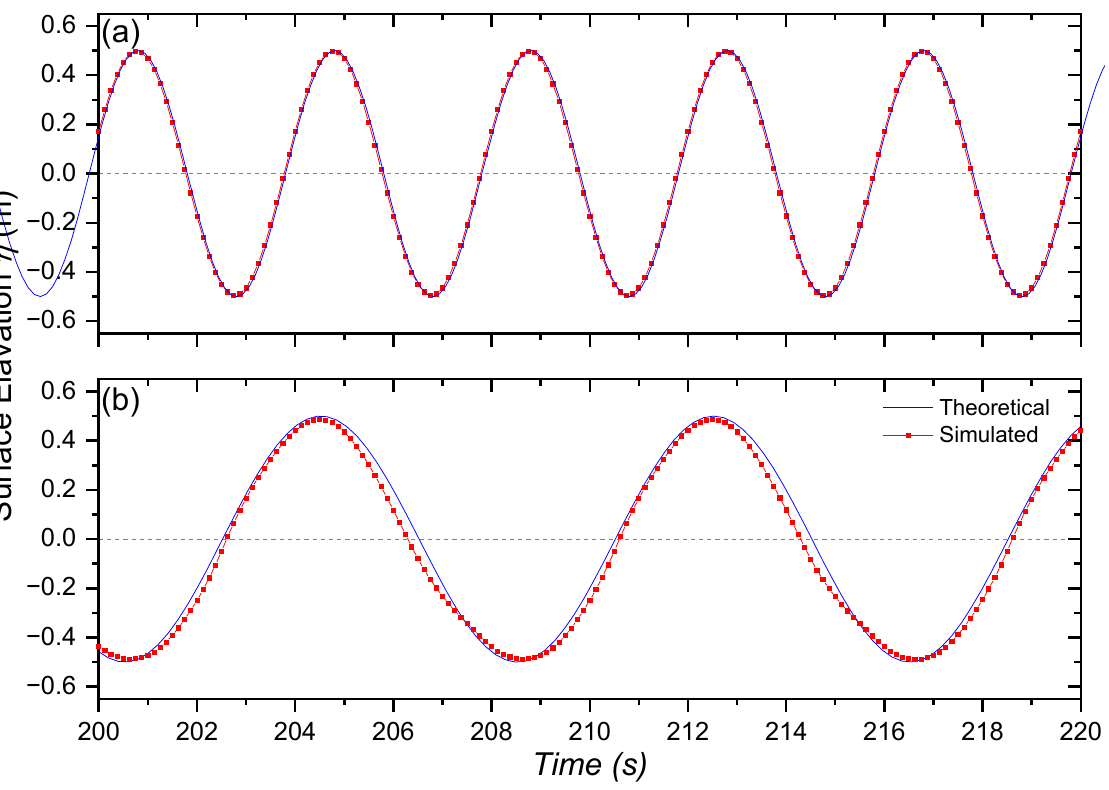
Figure 4. Comparison of the surface wave elevation ( η ) at the NWT inlet calculated with the theoretical result and simulation: ( a ) for T = 4 s and ( b ) for T = 8 s, with H = 1 m in both cases. The NWT considers the R 2 buoy.